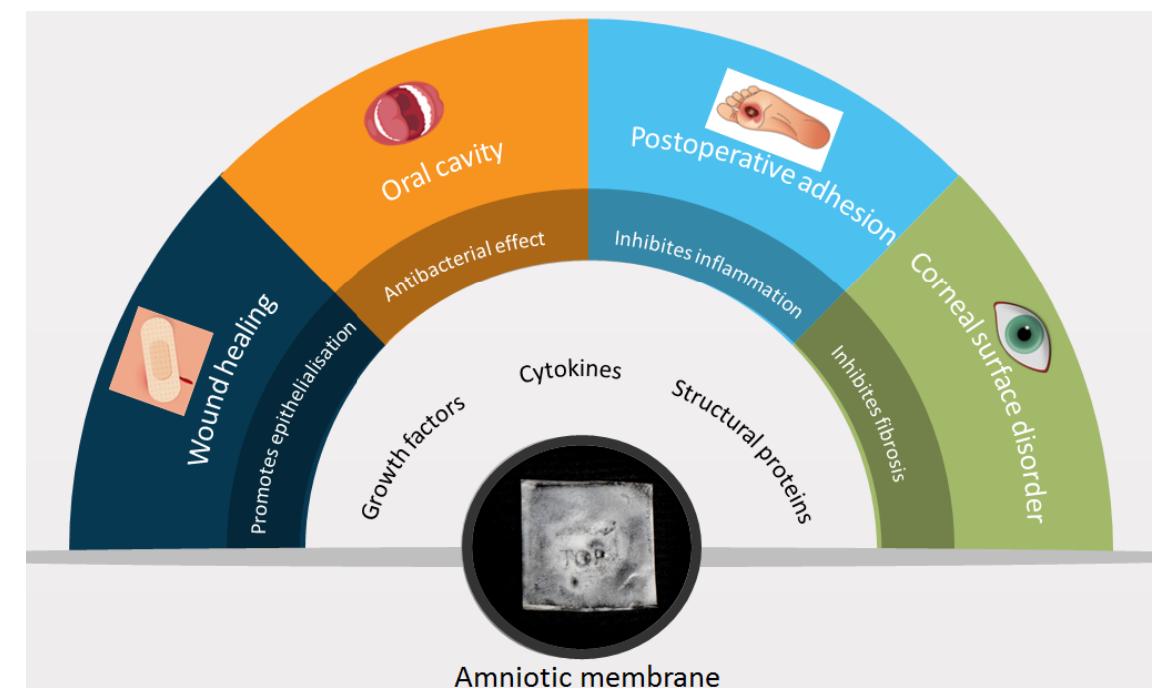
Figure 2. Amniotic membrane components, characteristics, and applications; data collected from cited articles.